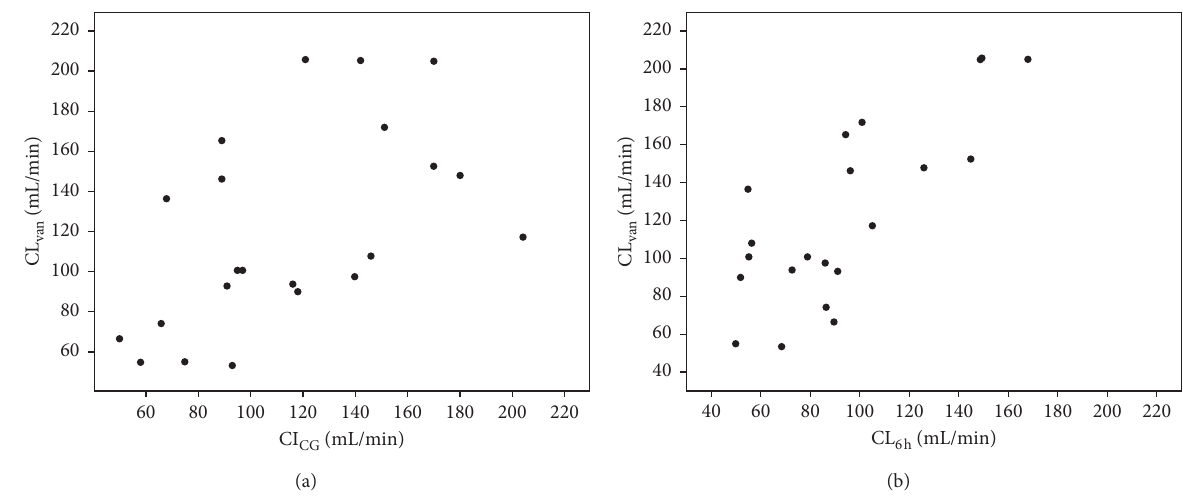
Figure 1: Comparisons between CL van , CL 6h , and CL CG . (a) Correlation between CL van and CL CG . (b) Correlation between CL van and CL 6h . Abbeviations: CL van : clearance of vancomycin, CL 6h : measured creatinine clearance in 6-hour urine collection, CL CG : estimated creatinine clearance by the Cockcroft–Gault formula.